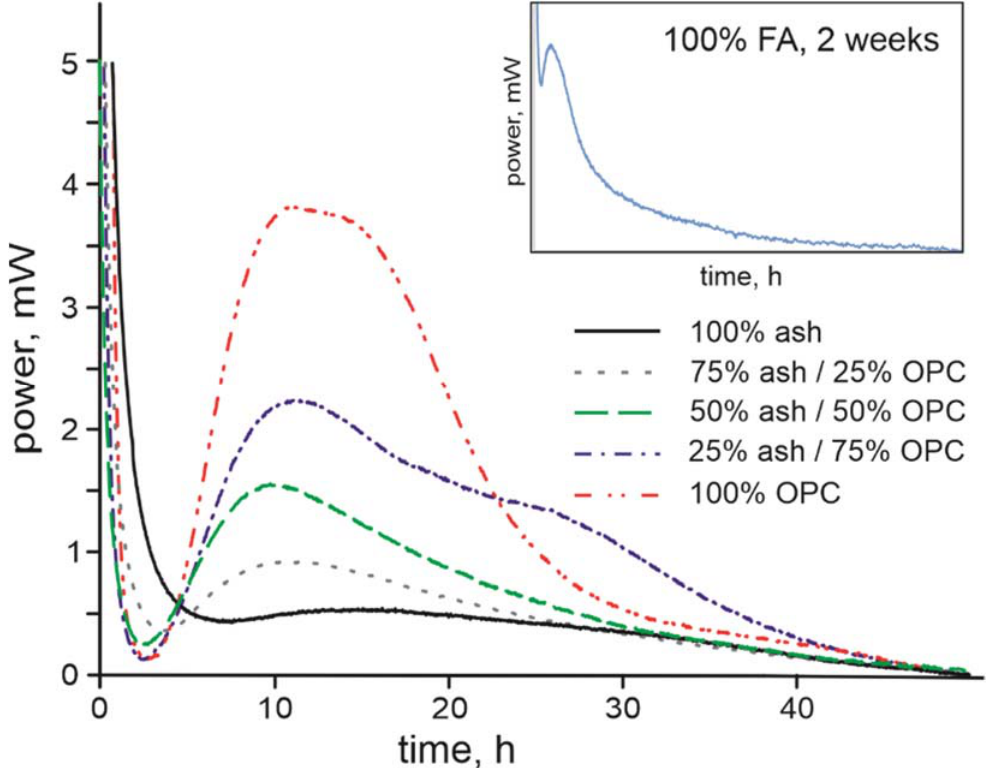
Figure 4. Isothermic calorimetric heat dispersion (mW) graphs of FA-CSA and OPC pastes over 48-h timeframe. The insert shows the heat dispersion from the pure FA-CSA paste measured over two weeks.